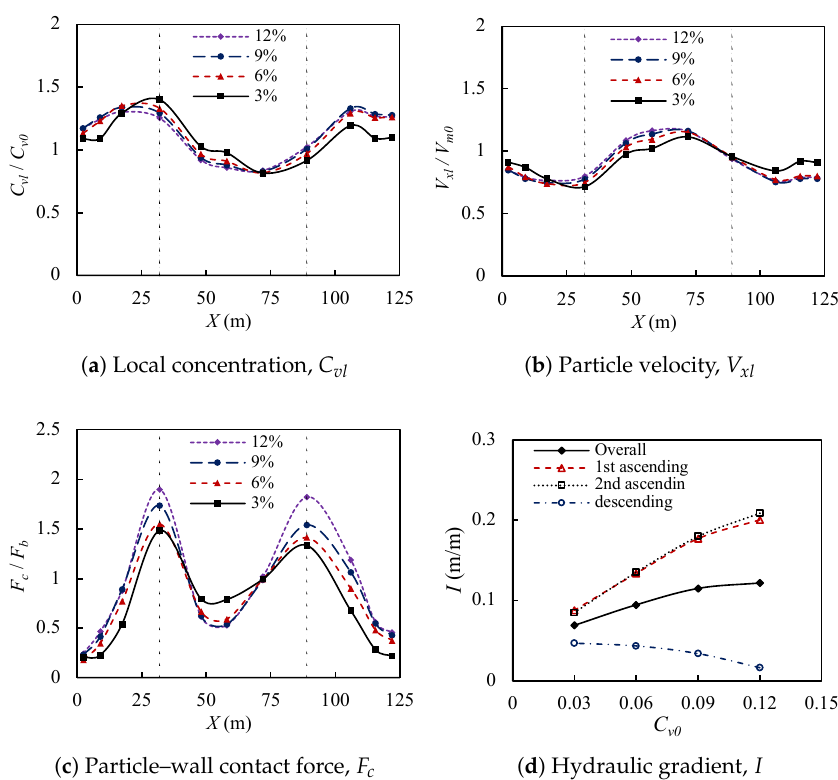
Figure 12. Effect of feeding concentration C v 0 (at V m 0 = 5